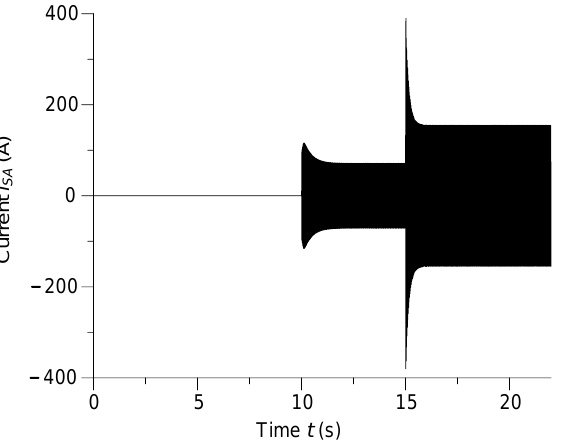
Figure 6. Instantaneous current in the A-phase winding of the shaft generator armature. In order to excite a magnetic field in the shaft generator, a current, i f , flows in the excitation winding. Its time course is shown in Figure 7.